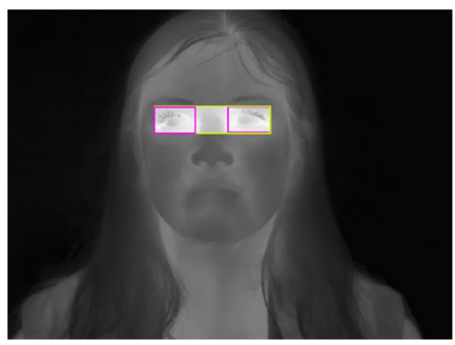
Figure 3. Example of the labeled image; pink box: one eye class, yellow box: two eyes class. For the elderly dataset, the labeling is limited to the two eyes class, which is simply called eyes. This is due to using the two eyes box exclusively later in the methodology.